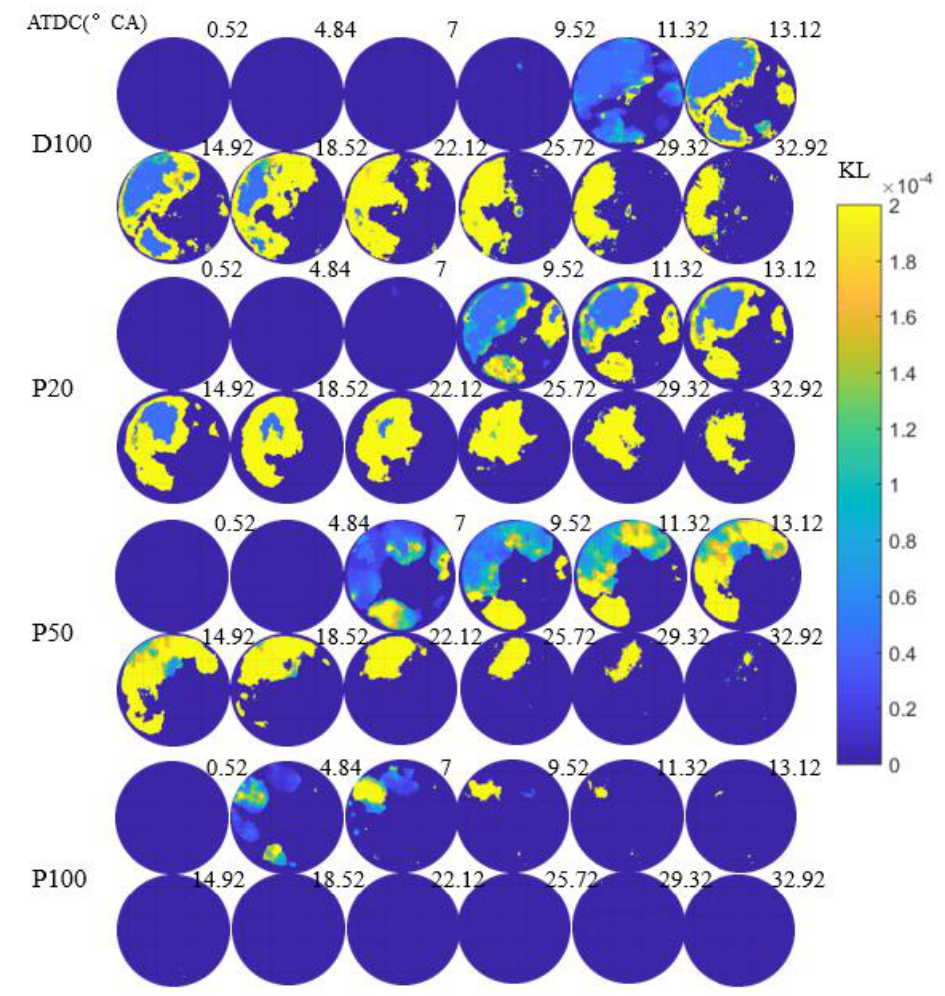
Figure 6. Spatial KL distribution (Injection pressure: 100 MPa; Injection timing: 6 °CA BTDC).